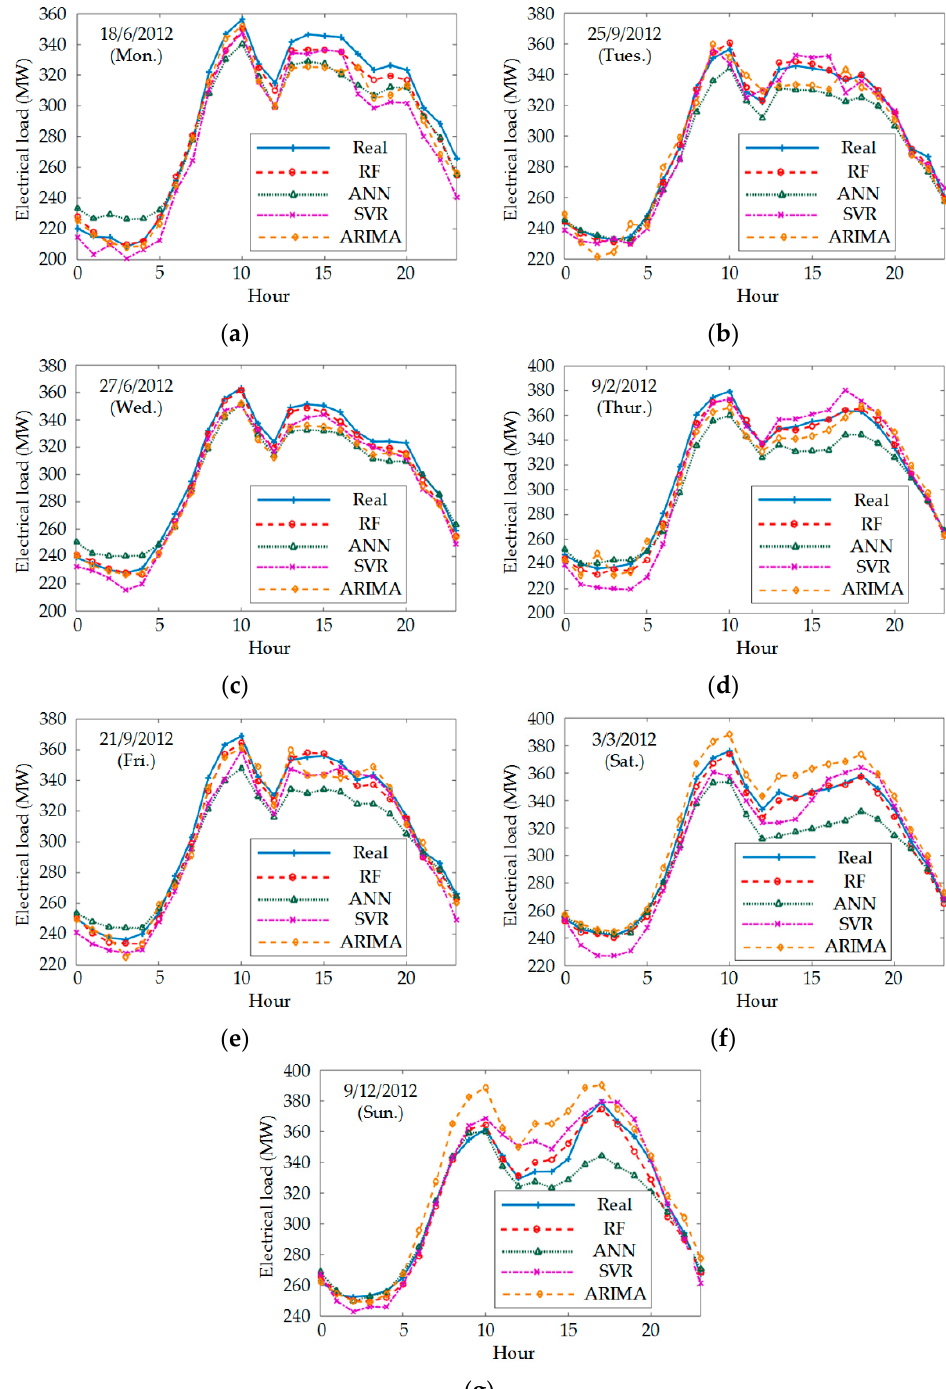
Figure 8. ( a ) The comparison of prediction results obtained from day ‐ ahead prediction of June 18th; ( b ) the comparison of prediction results obtained from day ‐ ahead prediction of September 25th; ( c ) the comparison of prediction results obtained from day ‐ ahead prediction of June 27th; ( d ) the comparison of prediction results obtained from day ‐ ahead prediction of February 9th; ( e ) the comparison of prediction results obtained from day ‐ ahead prediction of September 21st; ( f ) the comparison of prediction results obtained from day ‐ ahead prediction of March 3rd; ( g ) the comparison of prediction results obtained from day ‐ ahead prediction of December 9th.